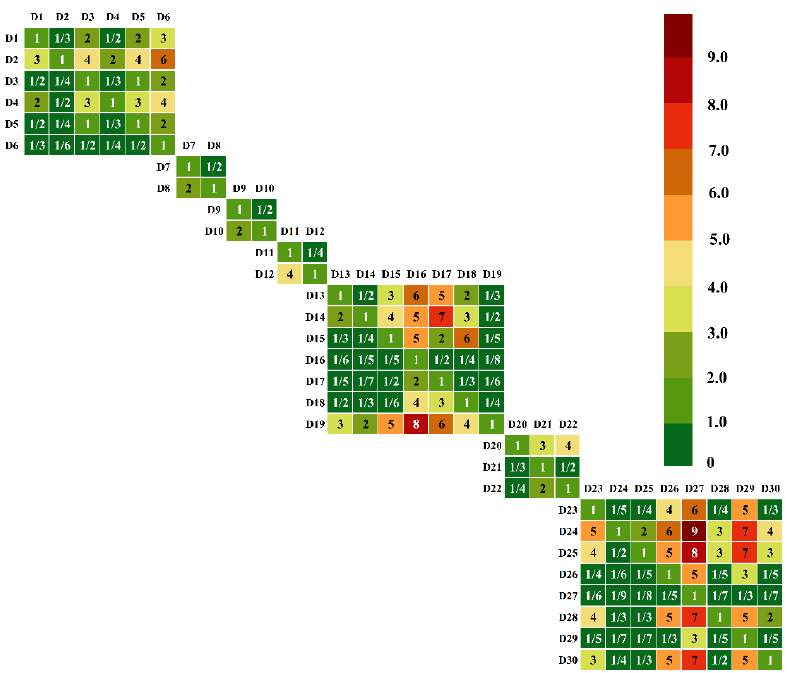
Figure 4. C1–C7 judgment matrix constructed by the analytic hierarchy process method. By checking the consistency of the matrix, the maximum eigenvalue λ max and the con- sistency index CI of each matrix was calculated (Table 2). All the matrices with CR < 0.1 were considered to be consistent [24]. Table 2. C1–C7 consistency test results. C